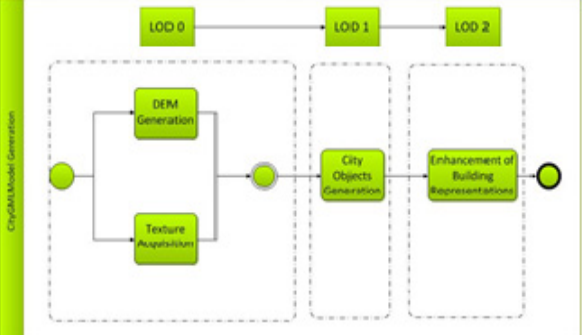
Figure 1. A summary view of 3D City Model generation